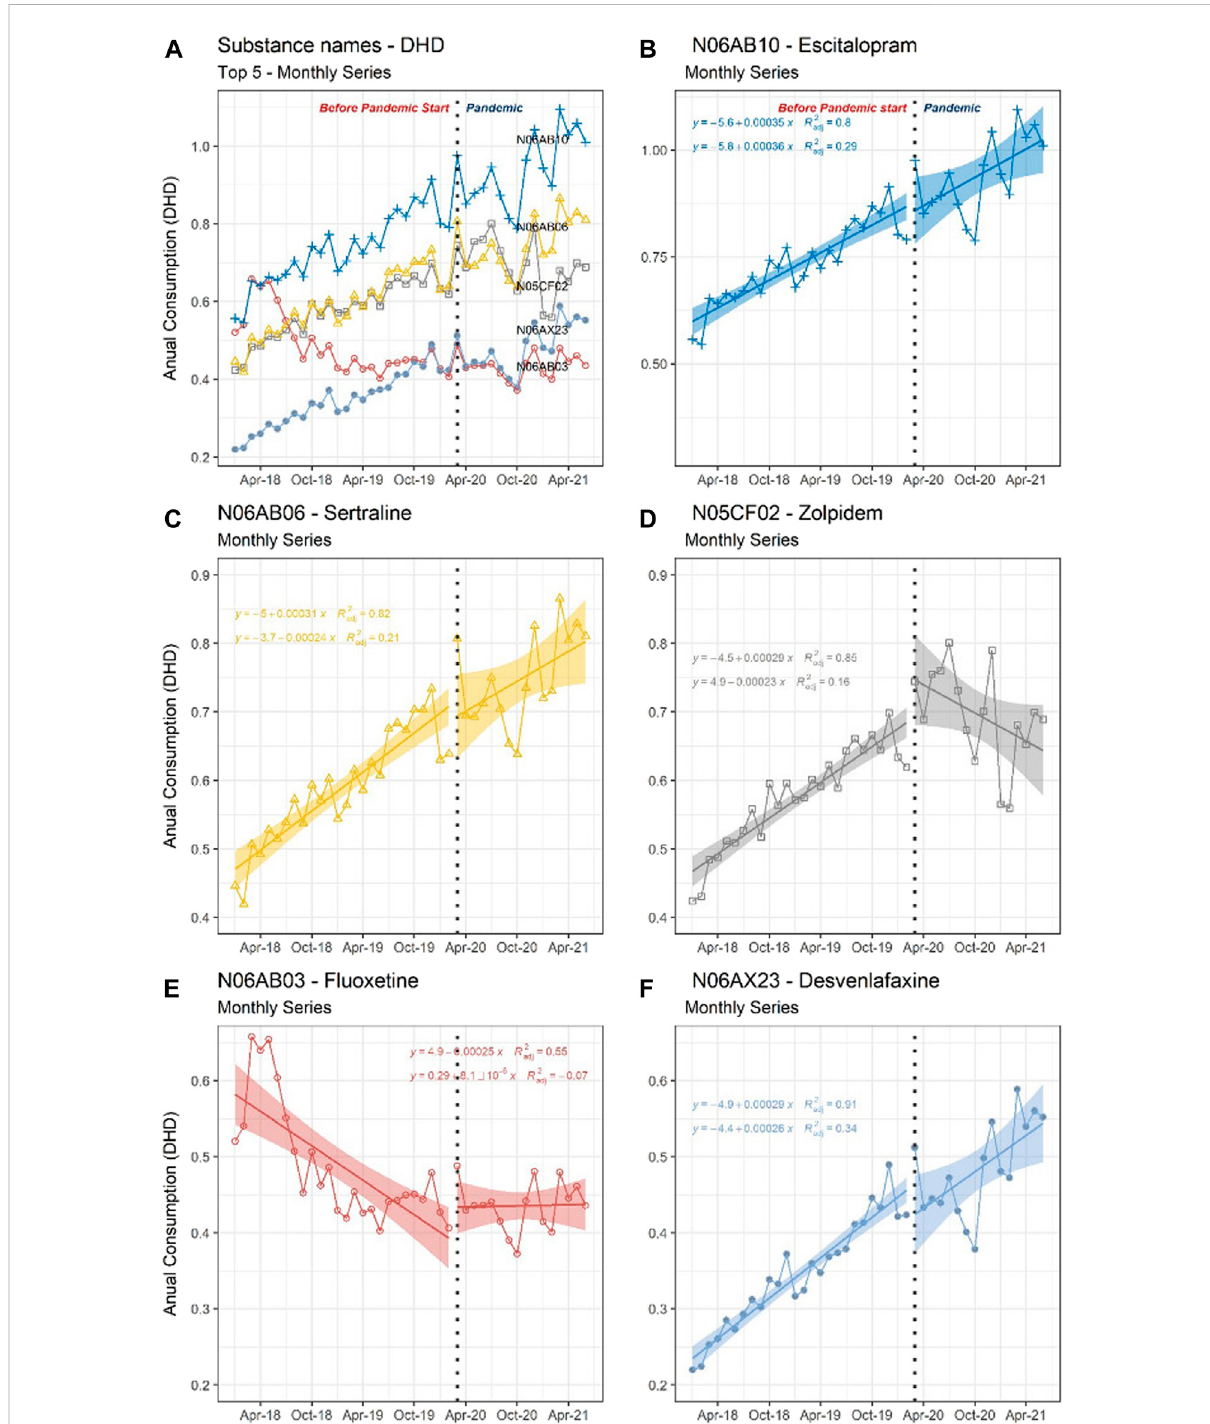
FIGURE 2 Interruptedtimeseriesofthe fi vemostdispendedmedications,2018to2020,withsanitaryinterruptionmarkedinMarch2020.Theverticalaxis displays the monthly consumption measured in adjusted DHD, and the horizontal axis displays the time measured in calendar months. The consumption trend of each drug is presented based on linear regression (95% CI) and the R2 value. The top 5 medication consumption trends are shown in graph (A) ; these Top 5 separated consumption trends are shown in graphs (B – F) : N06AB10 - Escitalopram (B) , N06AB06 - Sertraline (C) , N05CF02 - Zolpidem (D) , N06AB03 - Fluoxetine (E) , and N06AX23 - Desvenlafaxine. DHD, De fi ned Daily Dose per 1000